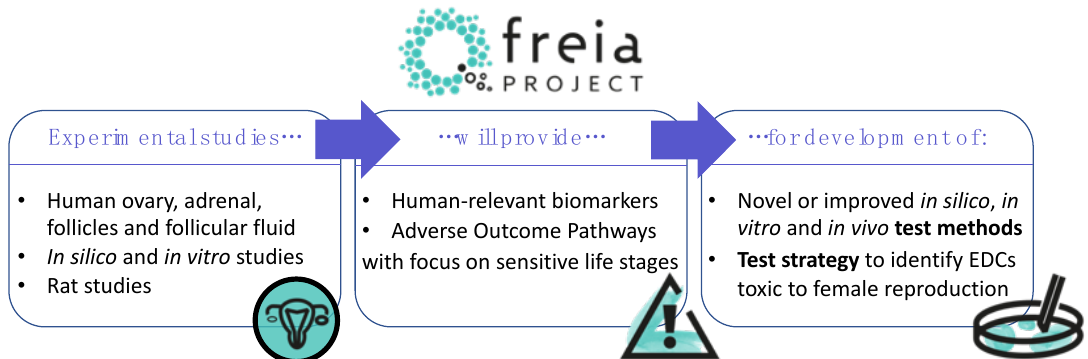
Figure 2. Experimental studies performed in the FREIA project will enable improved understanding of the harmful effects of endocrine disrupting chemicals (EDCs) on female reproduction. These studies will provide human-relevant biomarkers and adverse outcome pathways (AOPs) that will be used to develop dedicated test methods to identify EDCs that cause female reproductive toxicity.